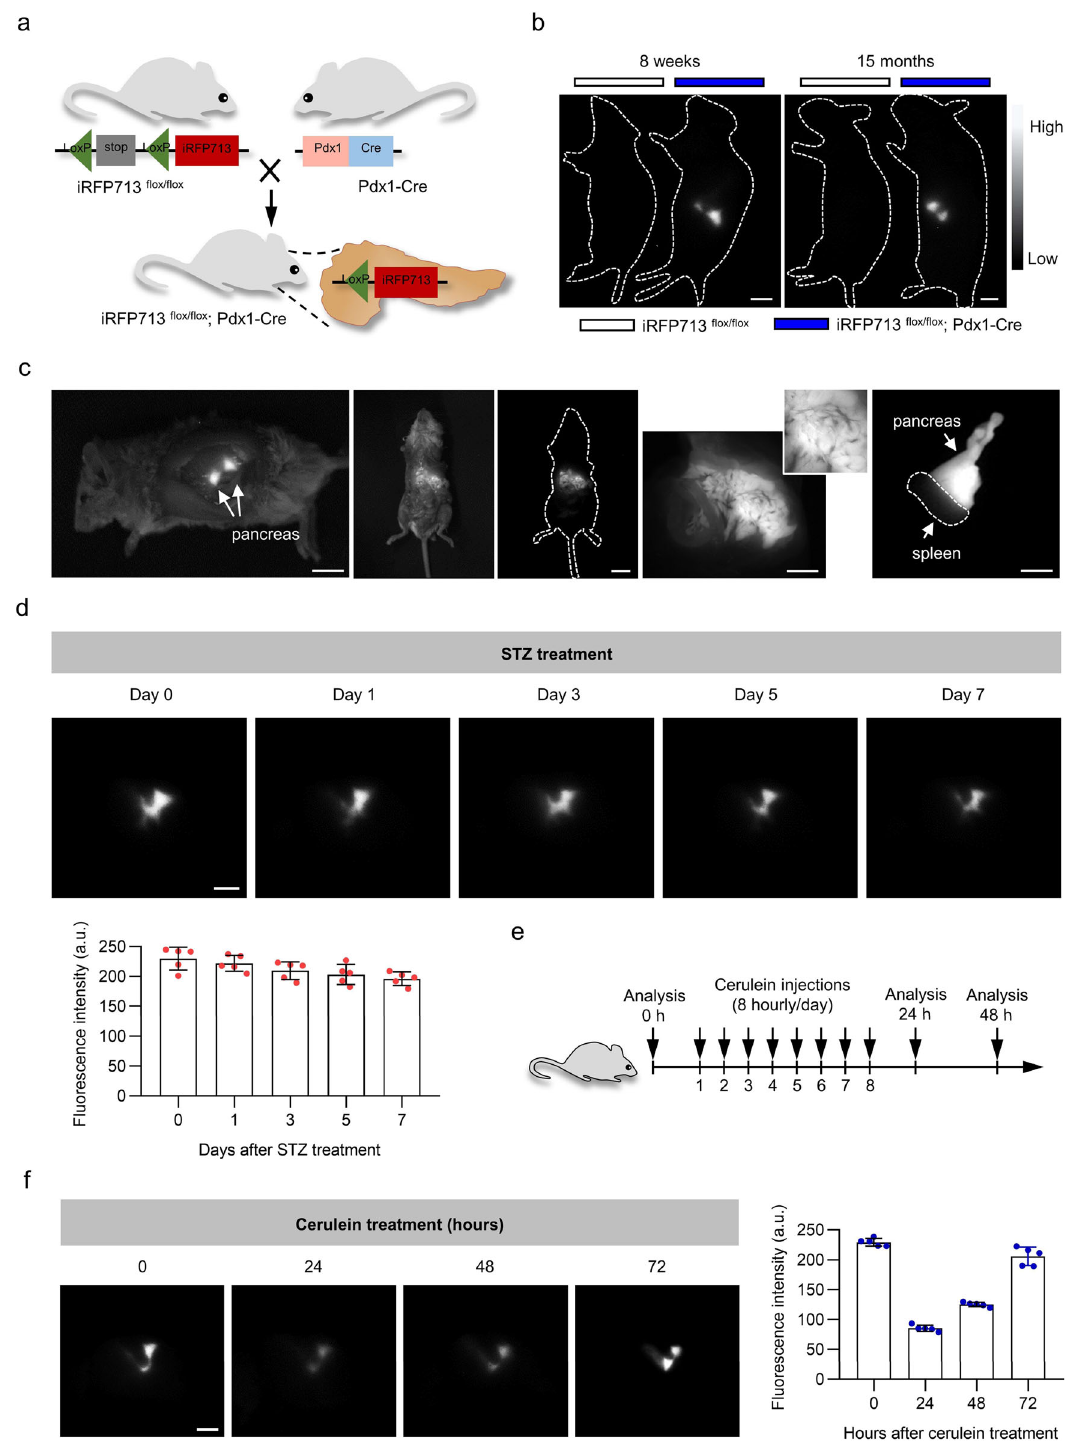
fl uorescence intensity quanti fi cation for the pancreas is shown in the lower panel ( n = 5 mice). e Brief description of the cerulein-induced pancreatitis experiment. Mice were administered 8 hourly doses of cerulein to induce acute pancreatitis. f NIR-II fl uorescence imaging of the pancreas for iRFP713 fl ox/ fl ox ; Pdx1-Cre mice at various time points (0, 24, 48, 72hours) after cerulein injections. Fluorescence intensity quanti fi cations are shown to the right ( n = 5 mice). Data presented as mean values±SEM. Exposure times: 20ms ( b, d, f ) and 10ms ( c ).Scale bars: 5mm ( b, d, f ) and 1cm ( c ).